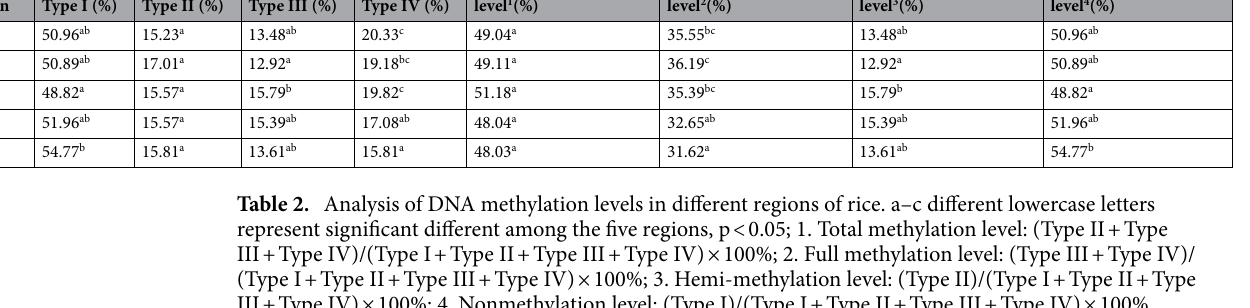
Percentage of polymorphic loci ( PLP